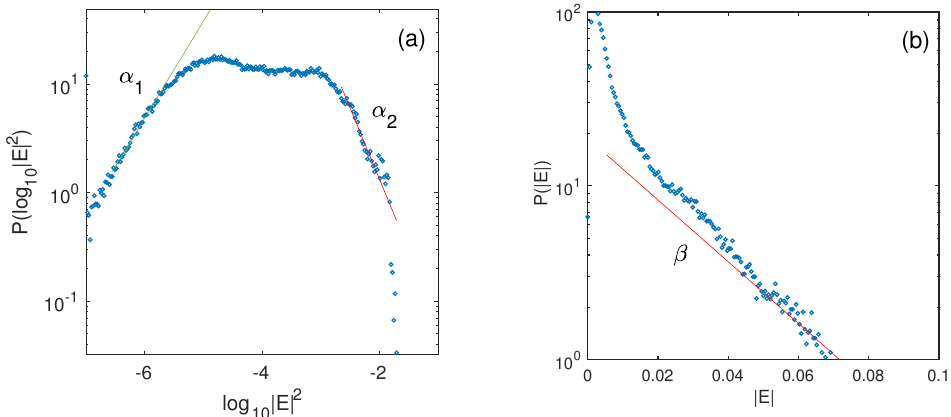
Figure 23. PDFs of the electric fields’ amplitudes averaged over the time interval ∆ T . ( a ) Distribution | E | 2 with linear fits of slopes α (cid:39) 2.1 and α (cid:39) − 5.3. ( b ) Distribution of | E | , with a linear fit at of log 2 1 10 large | E | of slope β (cid:39) − 3.8. Main parameters are: ∆ n = 0.01, n b / n 0 = 2 × 10 − 5 , ∆ T = [ 35,000,45,000 ] . Field and time variables are normalized, but not the PDFs. (Reproduced with permission from